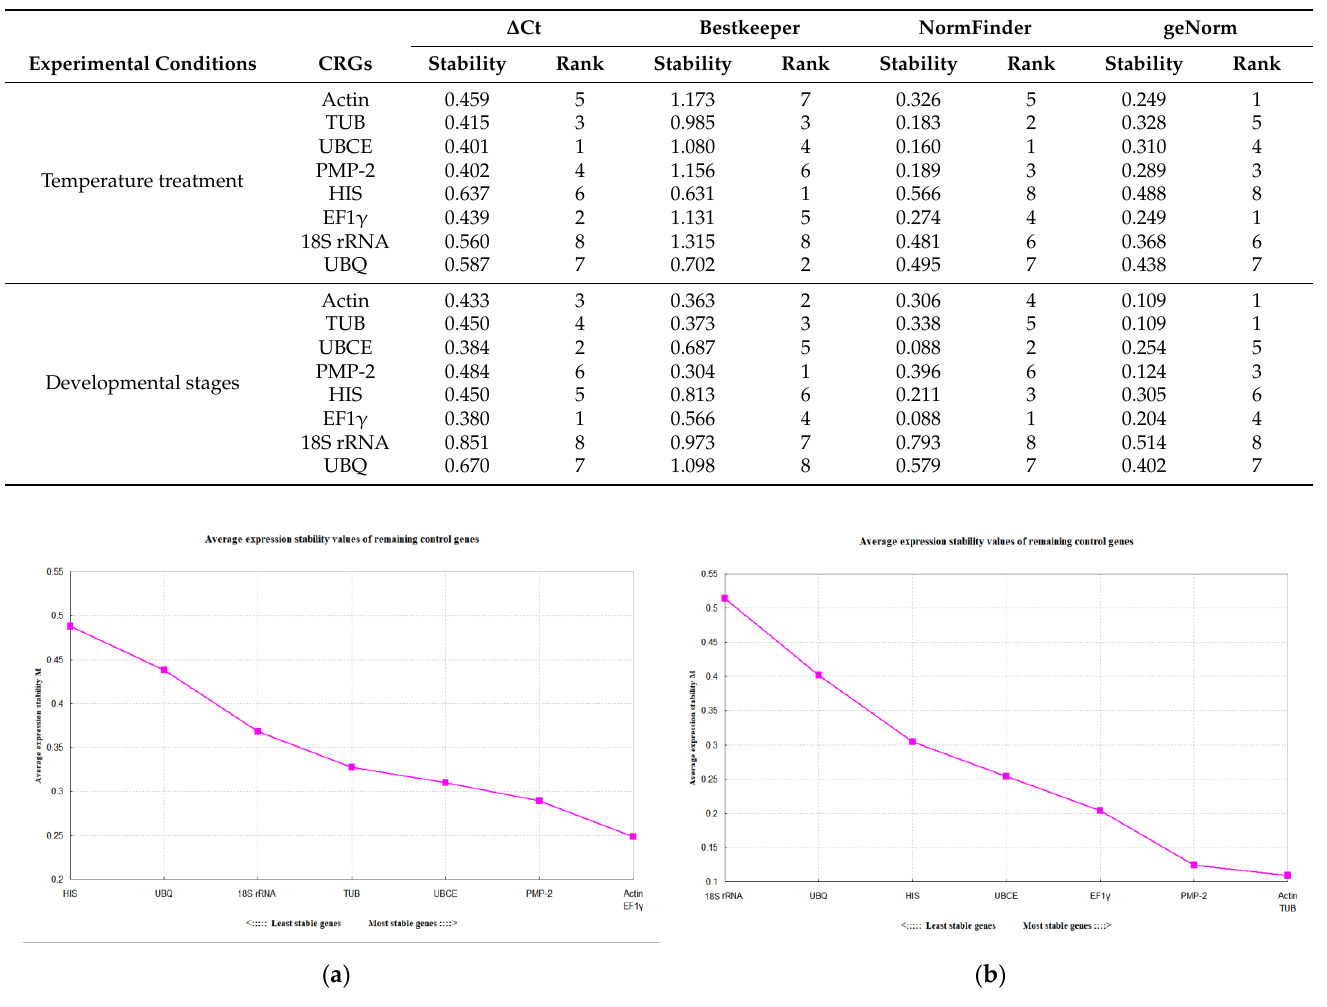
Figure 3. Average expression stability values (MV) of the candidate reference genes calculated by geNorm at ( a ) different temperature treatments and ( b ) different developmental stages.